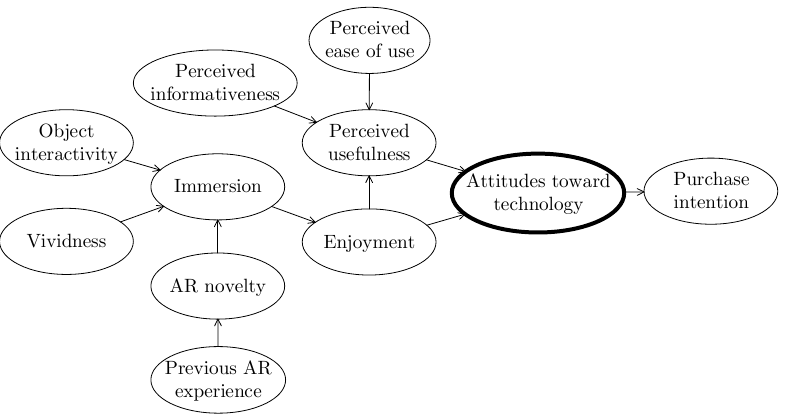
Figure 8. Conceptual framework of a consumer’s attitudes toward innovative